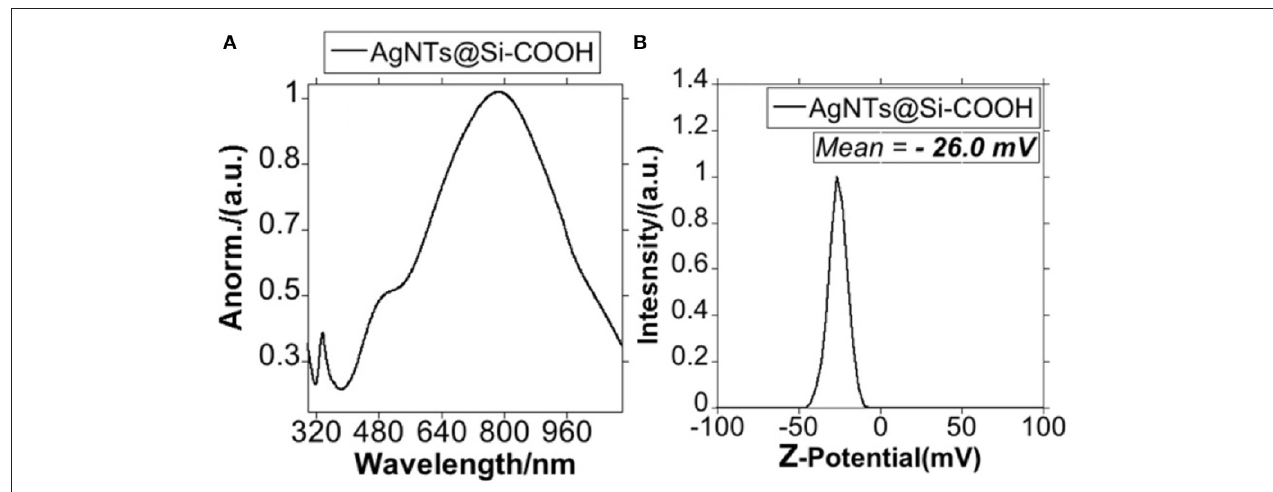
FIGURE 7 | Spectroscopic profile of AgNTs@Si-COOH (A) and graphic representation of the Z-potential for AgNTs@Si-COOH (B) .